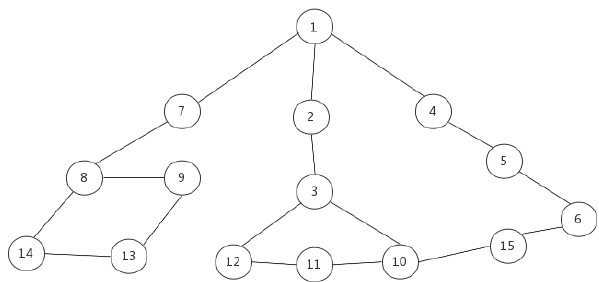
Figure 6. Modular configuration sequence of the special machine tool for VH-CATT cylindrical gears.